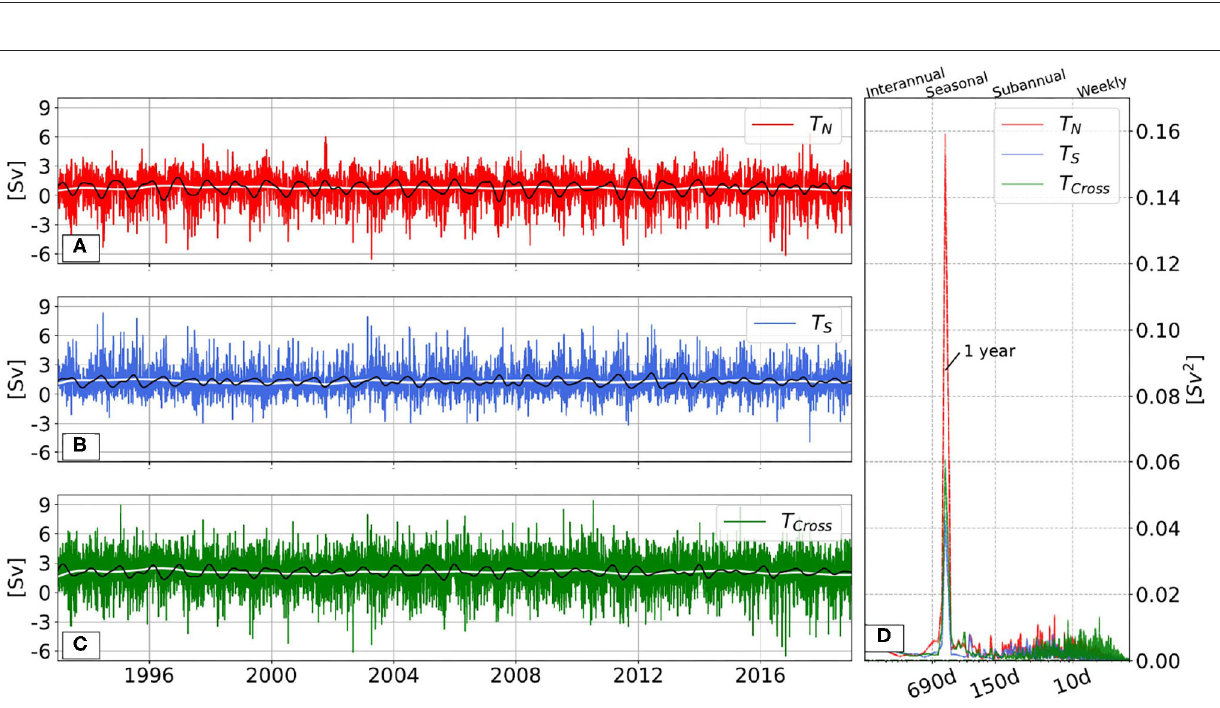
Frontiers in Marine Science |